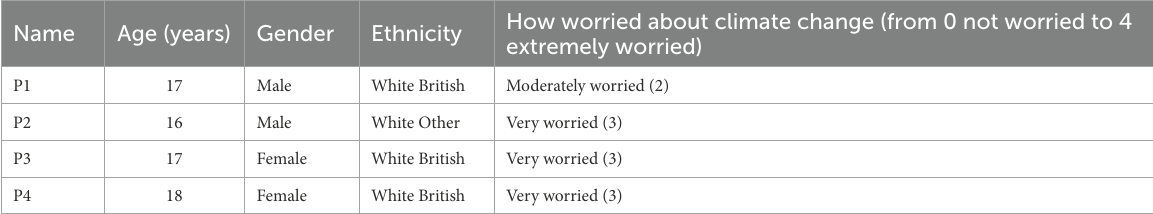
TABLE 2 Participant characteristics, including degree of current concern about climate